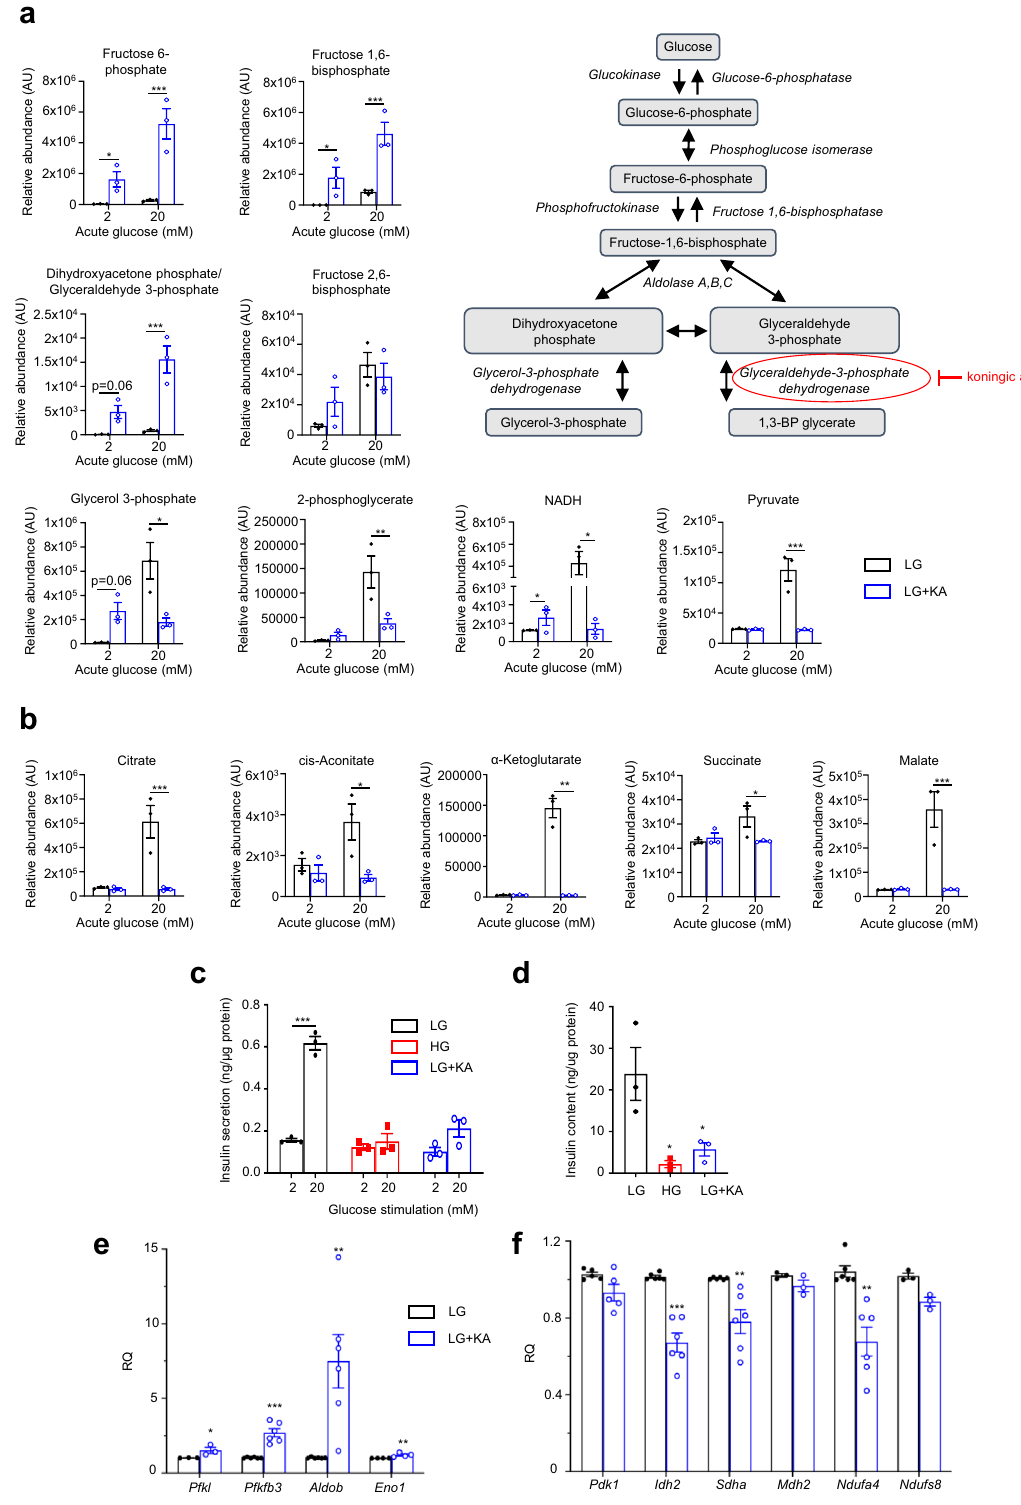
Fig.4|InhibitionofGAPDHinduceschangessimilartothosecausedbychronic hyperglycaemia. a Schematic of glycolysis showing where Koningic acid acts. a , b Glycolytic( a )andTCAcycle( b )metaboliteabundancesinLG-cellsculturedfor 48h without (black) or with (blue) 5 µ M koningic acid (KA) and subsequently sti- mulated with 2mM or 20mM glucose in the absence of KA ( n =3 biologically independent experiments). c , d Insulinsecretion( c ) and insulin content ( d ) in HG- cells(red)andinLG-cellsculturedintheabsence(black)orpresence(blue)of5 µ M KAfor48hand thenstimulated with2mMor20mMglucoseintheabsenceofKA